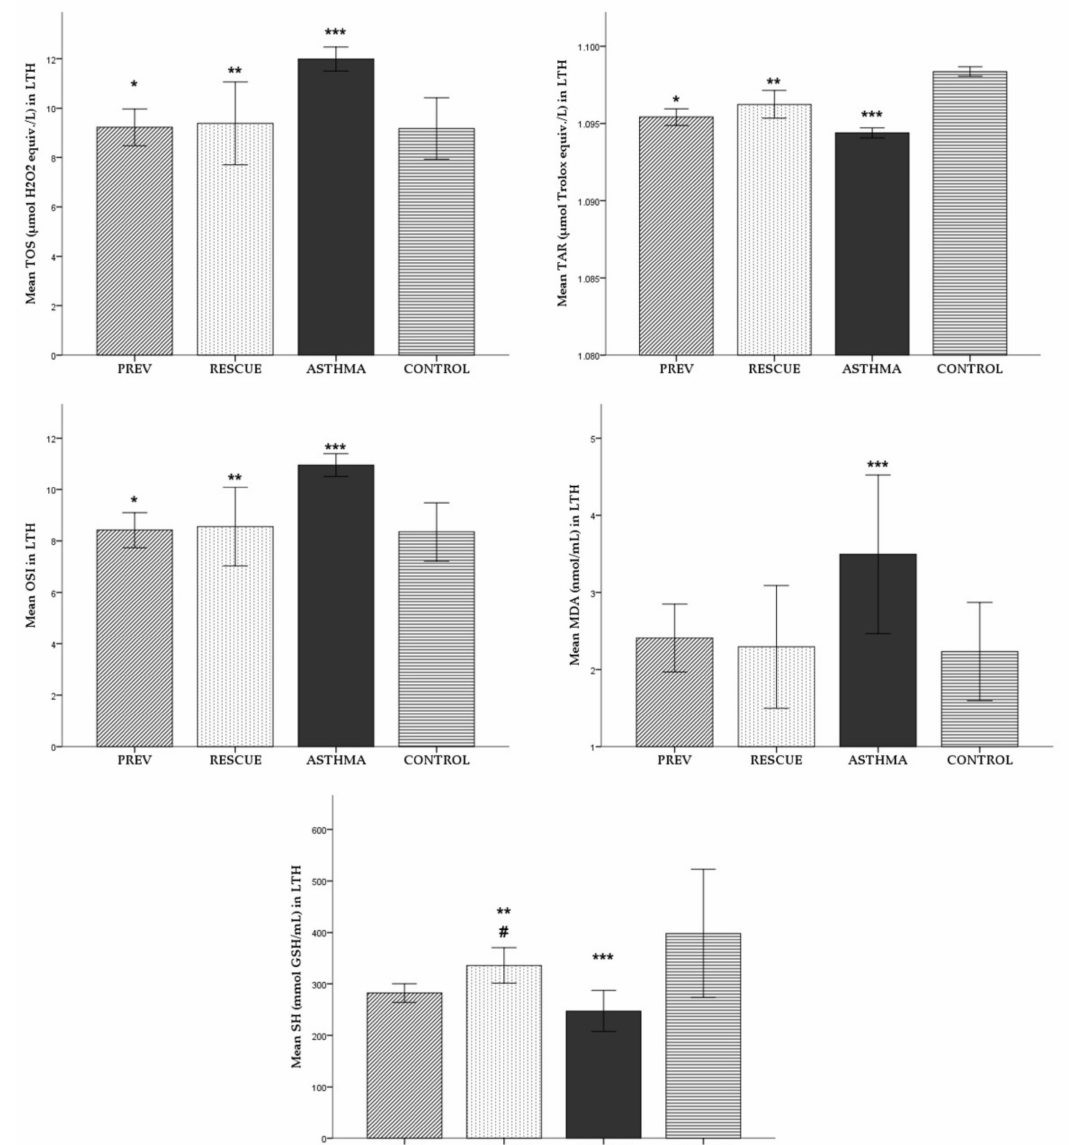
Figure 3. Mean levels ( ± standard deviation) of oxidative stress parameters in LTH. Comparison between experimental groups: * p < 0.05 PREV versus ASTHMA group; ** p < 0.05 RESCUE versus ASTHMA group; *** p < 0.05 ASTHMA versus CONTROL; # p < 0.05 PREV versus RESCUE. Abbreviations: LTH = lung tissue homogenate, TOS = total oxidative status, TAR = total antioxidant response, OSI = oxidative stress index, MDA = malondialdehyde, SH = total thiols; PREV = long- term low-dose vitamin D supplementation, RESCUE = short-term high-dose vitamin D supplementation, ASTHMA = positive control, CONTROL = negative